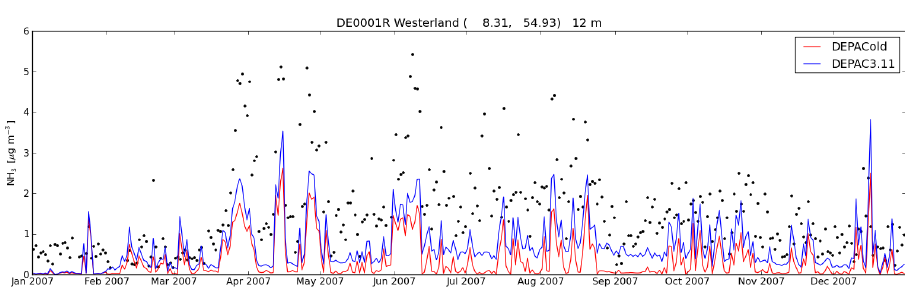
Figure 11. Time series for the measured and modeled ammonia concentrations with the 'DEPACold' module (red line) and the 'DEPAC3.11' module (blue line) at EMEP station Westerland in Germany in 2007. Black dots are the daily measurements. The grid resolution of the model results is 0.50° longitude x 0.25° latitude (~28x28 km 2 ).